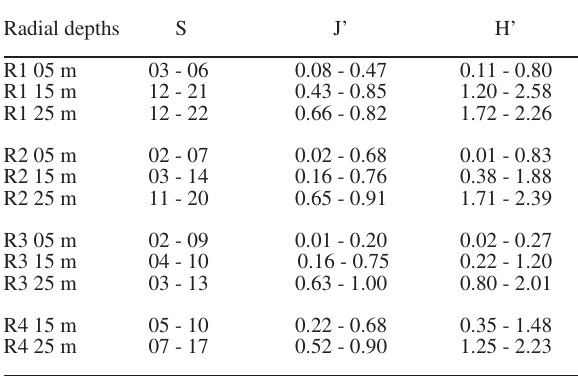
Table 5. – Ranges of values of specific richness (S), equitability (Pielou) (J’) and diversity (Shannon) (H’) by radials and depths (meters).